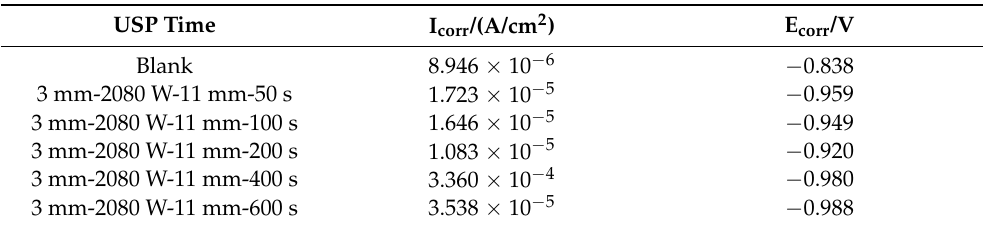
Figure 10. Electrochemical test polarization curves and line plot of the corrosion potential and corrosion current of samples with different lengths of USP time. Table 5. The parameters of the equivalent elements in the equivalent circuit of the samples with different lengths of USP